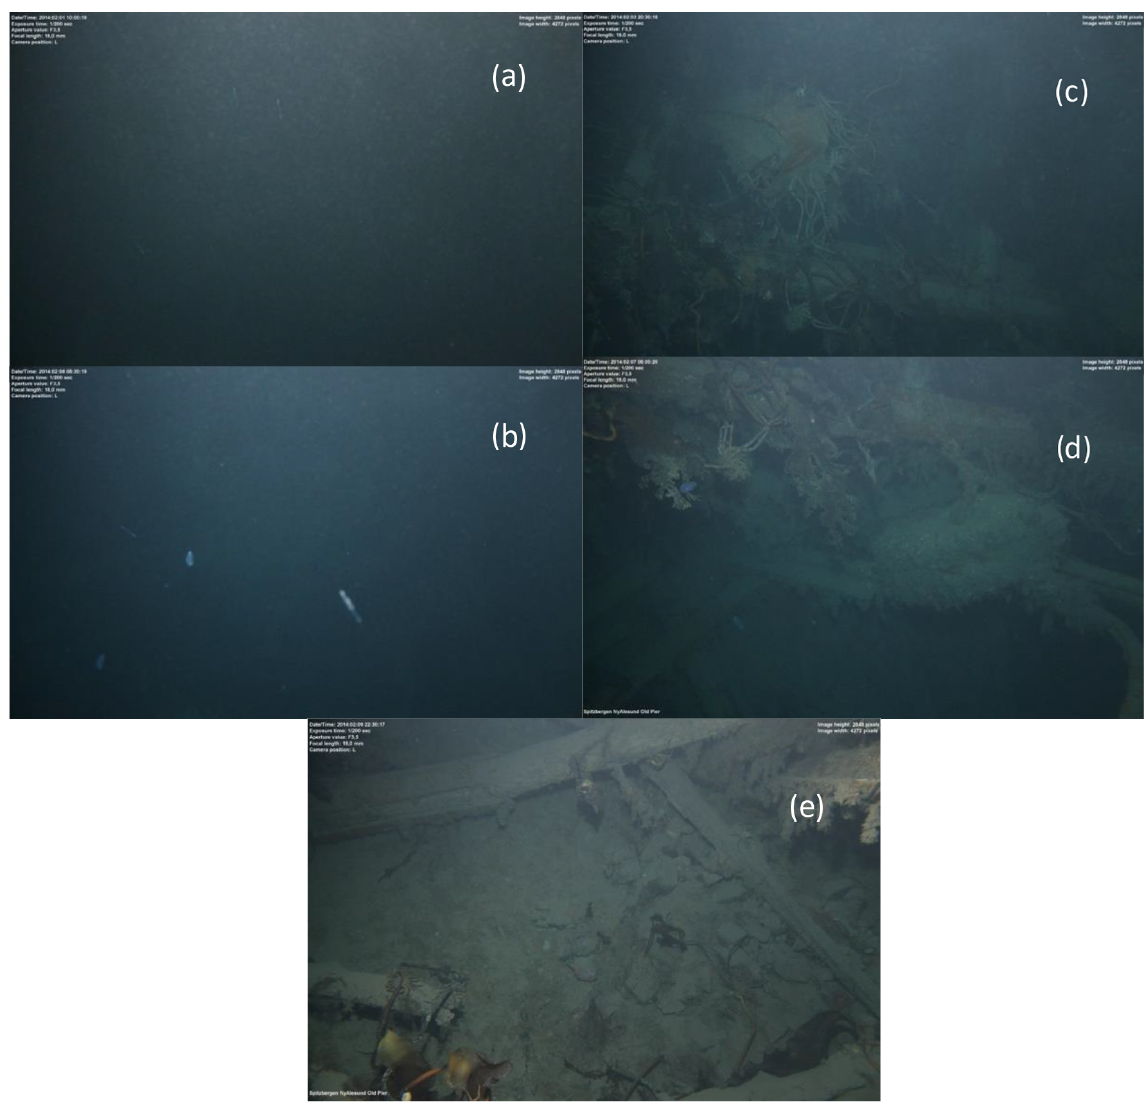
Figure 3. (a, b, c, d, e) View of the RemOs1 stereo-optical system in the five different depth strata. (a) Depth stratum 0–2m, (b) depth stratum 2–4m, (c) depth stratum 4–6m, (d) depth stratum 6–8m, and depth stratum (e)